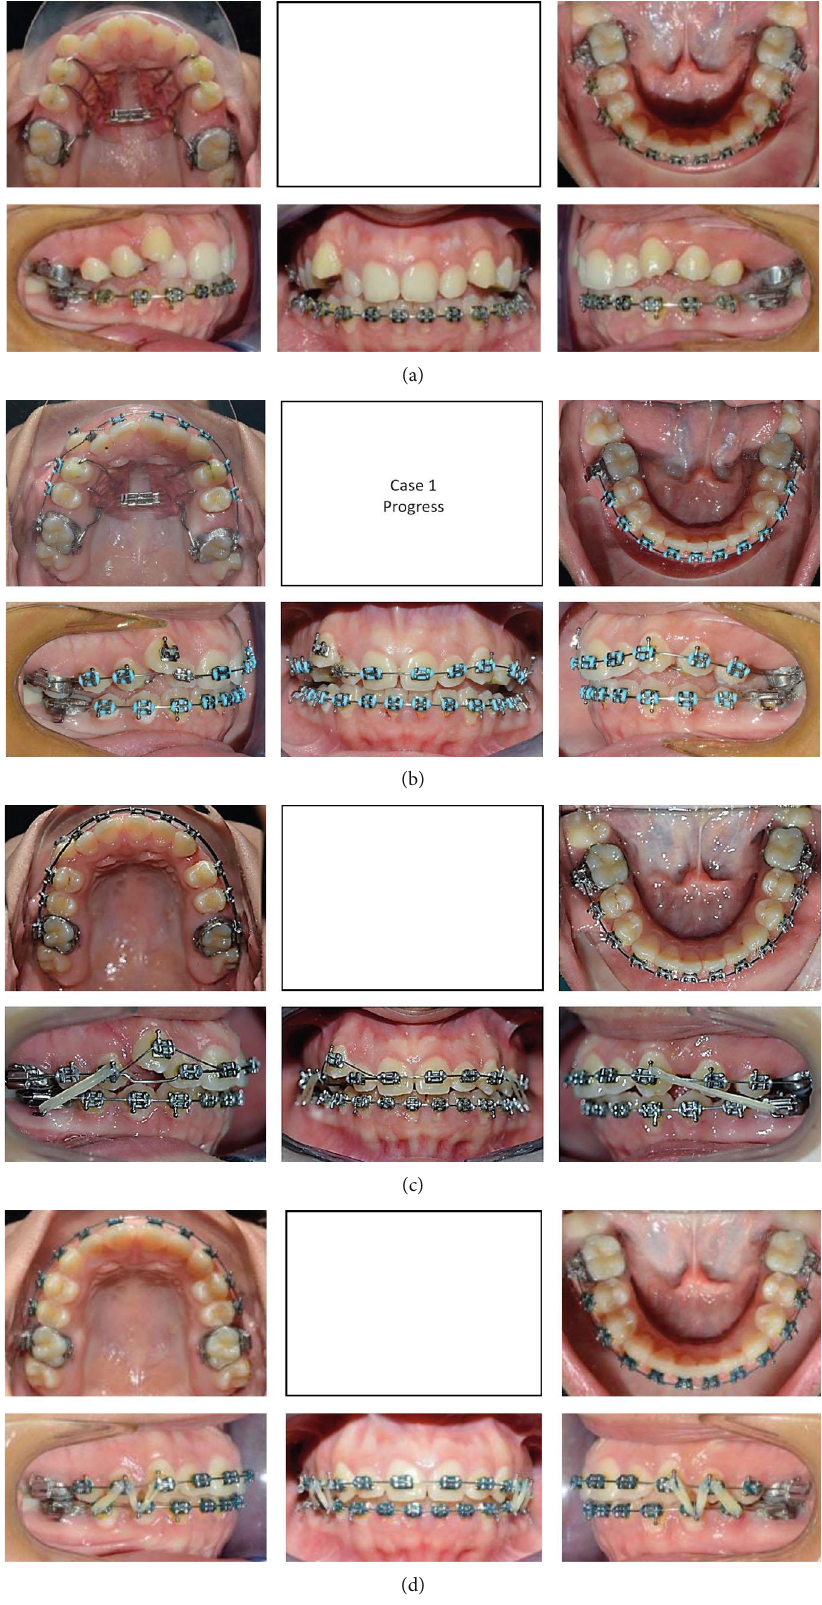
Figure 2: (a) Progress treatment intraoral photographs of the patient. (b) Progress treatment intraoral photographs of the patient. (c) Progress treatment intraoral photographs of the patient. (d) Progress treatment intraoral photographs of the